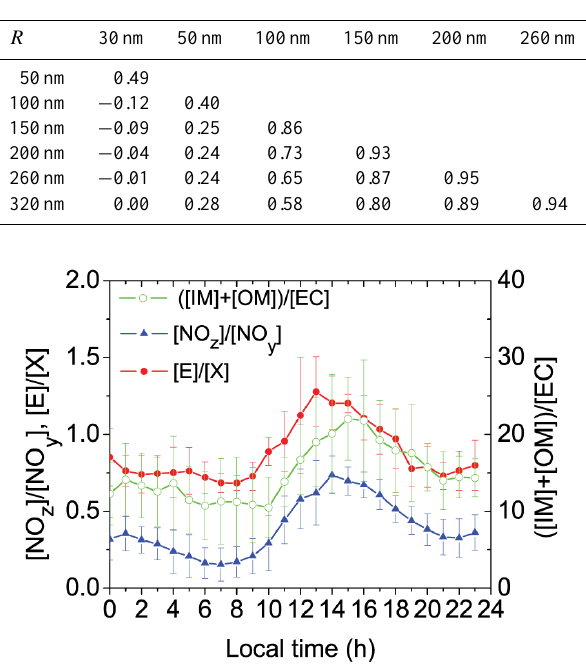
Fig. 4. Averaged diurnal variation of [NO z ]/[NO y ], [E]/[X] and ( [ IM ]+[ OM ] )/ [ EC ] . Symbols represent arithmetic mean values and error bars represent the standard